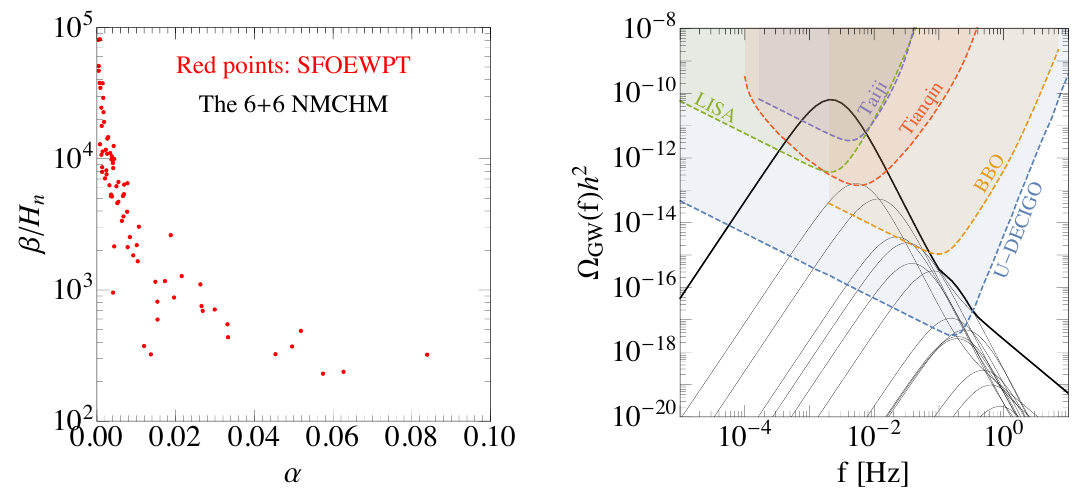
Figure 3 . Left: the (cid:11) and (cid:12)=H n distribution for the parameter points with SFOEWPT. Right: the GW signals, where the thin black lines are typical GW curves from the data points of the left panel, while the thick black line represents the envelope of all data